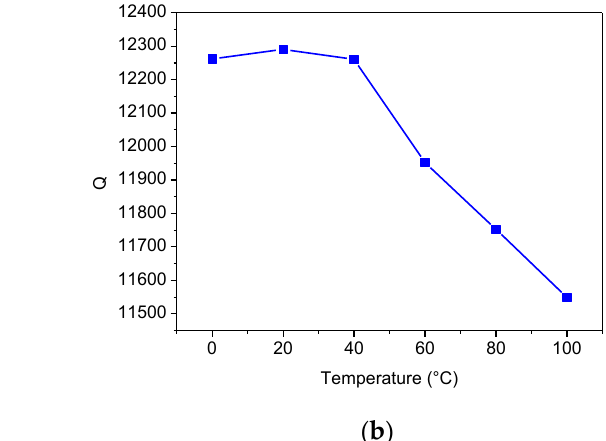
Figure 12. Temperature dependence of ( a ) the resonant frequency and ( b ) Q factor.